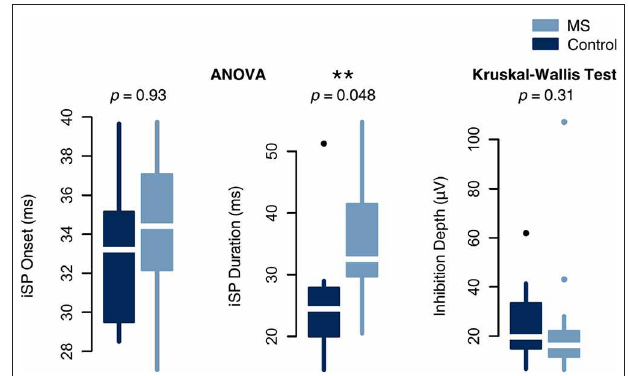
FIGURE 5 | Analysis of inter-group differences in normally distributed TCI measures by one-way ANOVA and non-normally distributed measures by the non-parametric Kruskal-Wallis test. iSP duration was significantly increased in MS whereas iSP onset and inhibition depth were not significantly different between